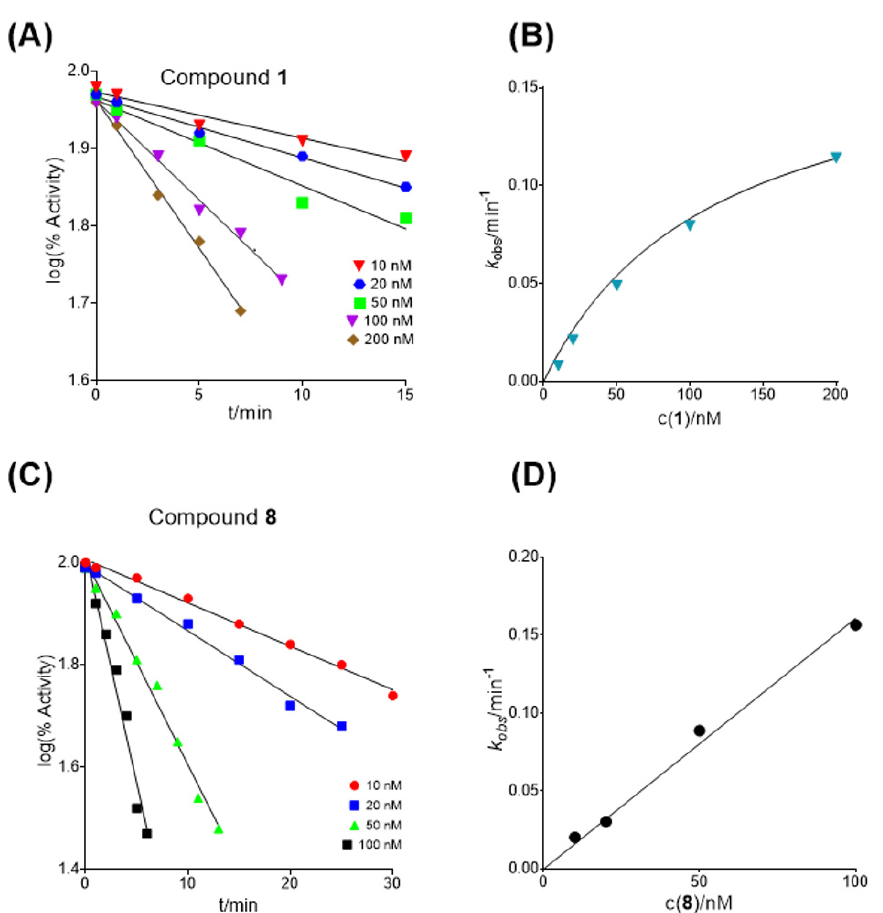
Figure 3. Representative experiment of inhibition of BChE by compounds 1 and 8 . Points in panels ( A , C ) indicate the logarithm of residual activity, while the slope of the lines determines the observed first-order rate constant k obs . On panels ( B , D ), constants k obs were plotted as a function of biscar- bamate concentration wherefrom the second-order rate constant, k i , was calculated. Compound 1 displayed a nonlinear dependence of the k obs on biscarbamate concentration (panel ( B )) allowing de- termination of the maximal first-order rate constant of carbamylation, k max , and dissociation constant of Michaelis type of complex between enzyme and inhibitor, K i , while k i is defined as their ratio. For biscarbamate 8 , k obs was a linear function of biscarbamate concentration (panel ( D )), and the slope defined the k i